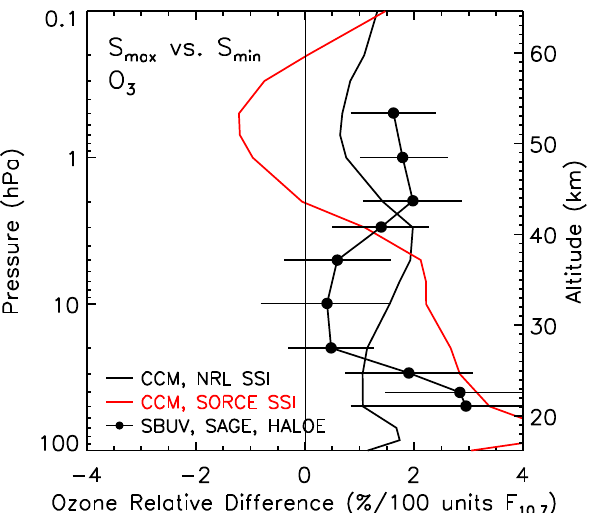
Fig. 4. Simulated ozone solar cycle response in the GEOSCCM us- ing both NRL and SORCE SSI, averaged over 25 ◦ S–25 ◦ N lati- tude. Also shown is the solar cycle variation in ozone deduced from SBUV, SAGE, and HALOE satellite measurements (Austin et al. (2008), Fig. 4; see also Soukharev and Hood,